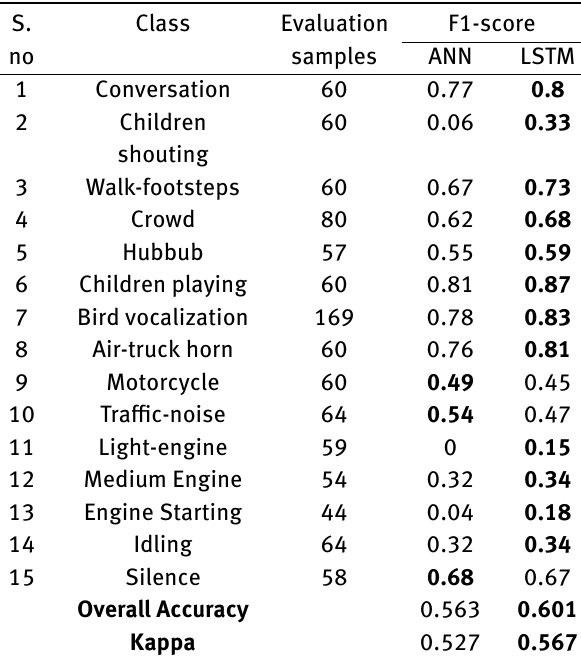
Table 2: Class-wise model performance of 15-class ANN and LSTM